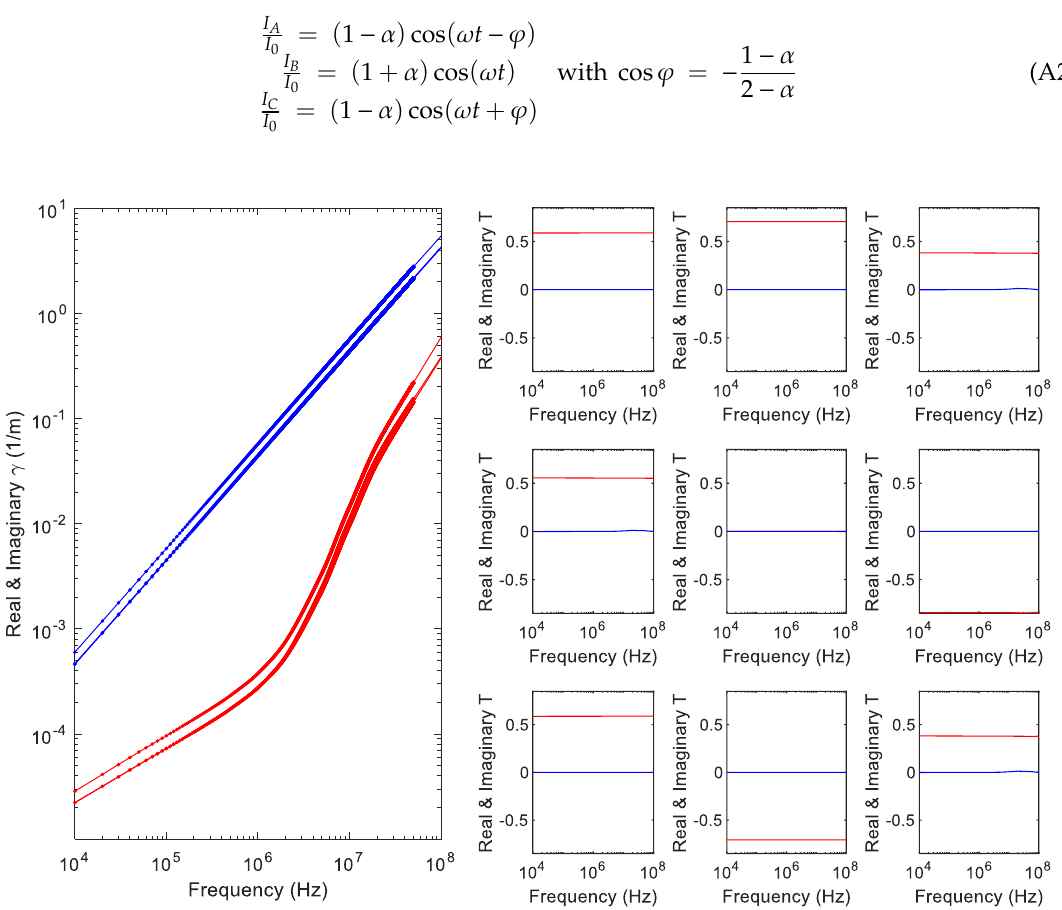
Figure A1. Resampling of the real ( red ) and imaginary ( blue ) terms of the propagation coefficients ( left ) and transformation matrix components ( right ) as a function of frequency.